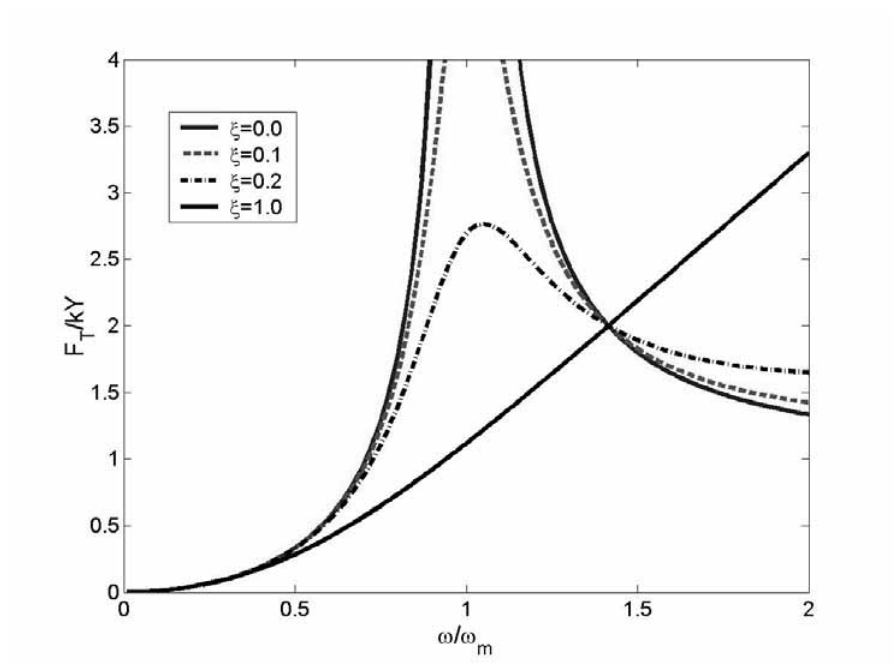
Fig. 2. Typical single degree of freedom mount transmissibility frequency response.